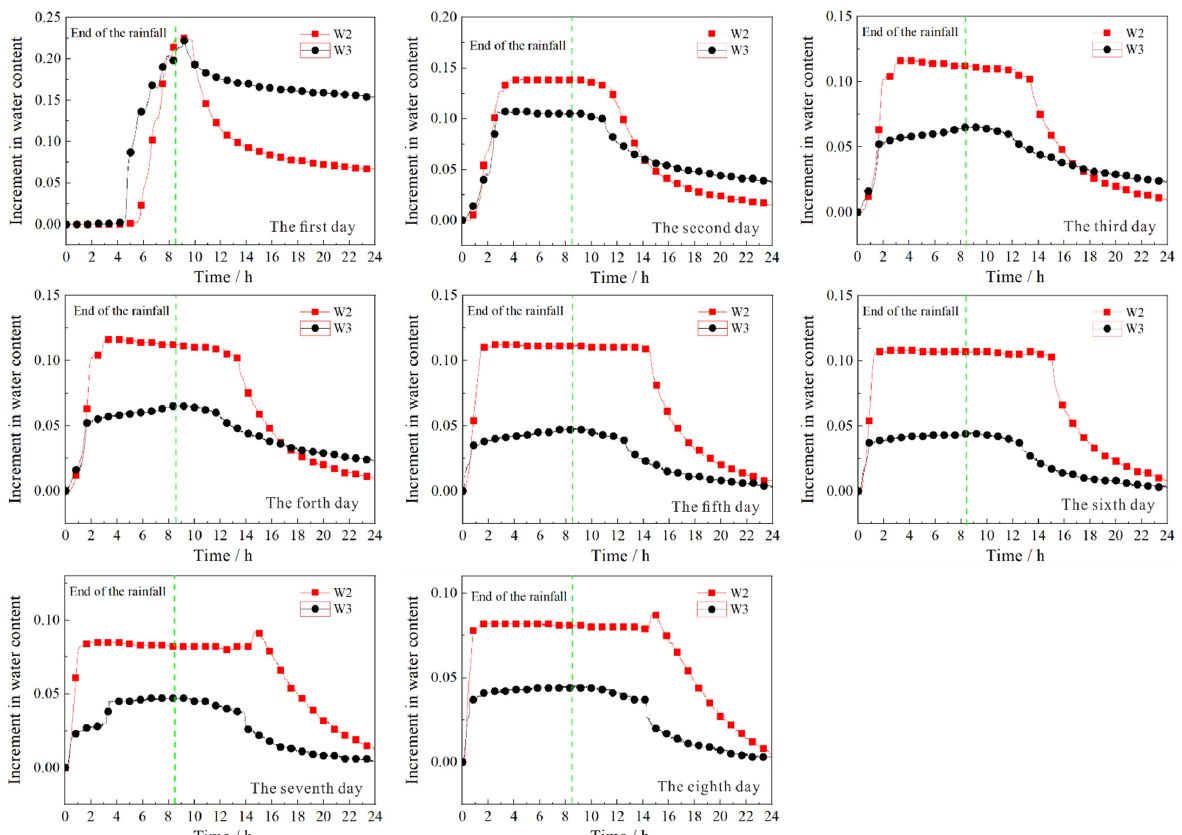
Figure 4. Variation of water content in the following days, from the first to the eighth (H1 = 1.0 m).